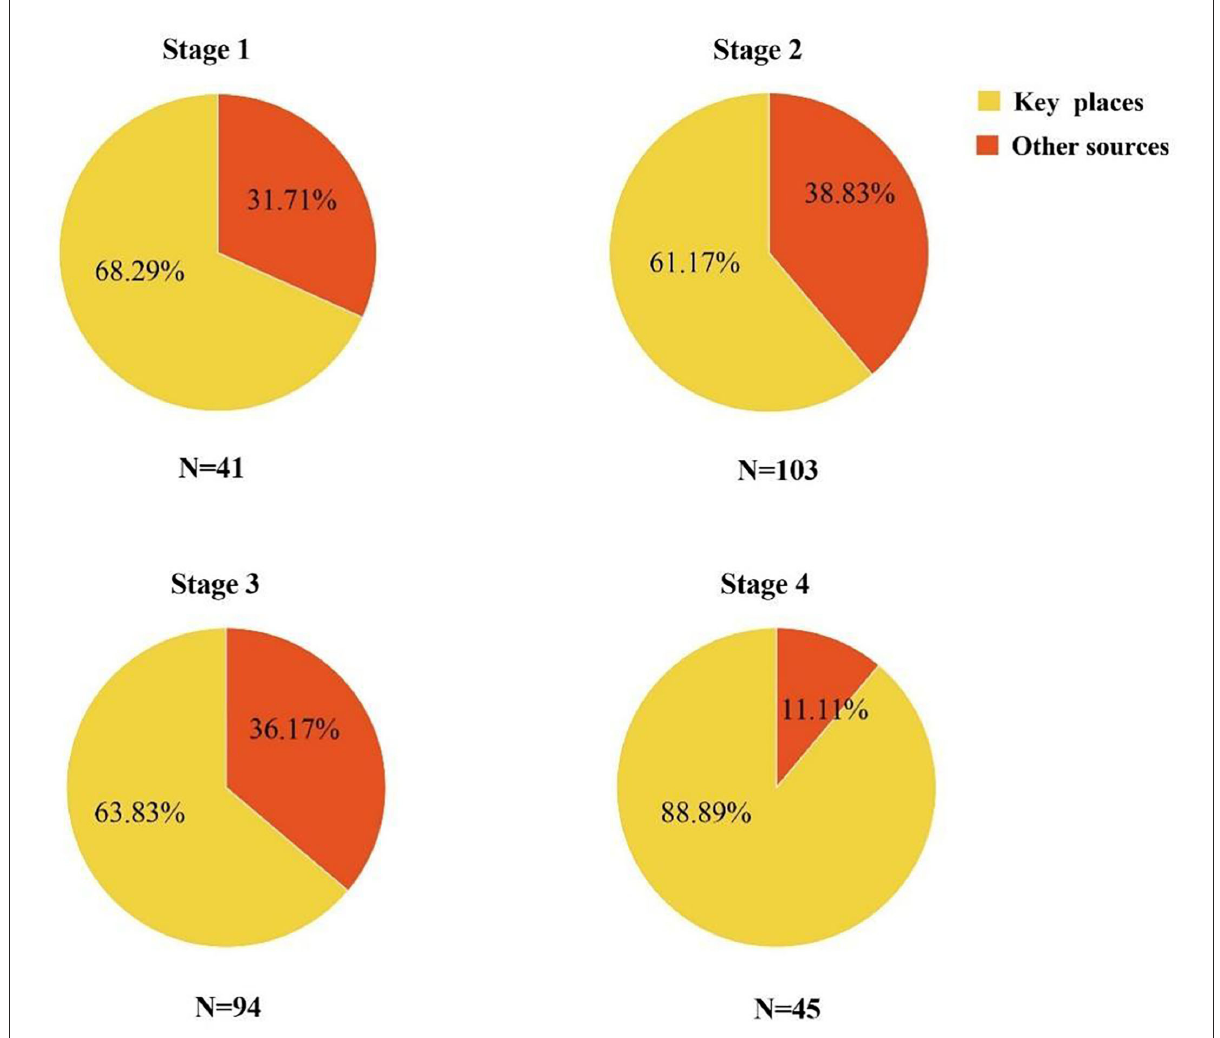
FIGURE4 The case-finding source at each stage. Other case-finding sources include mass testing, fever clinic, and close